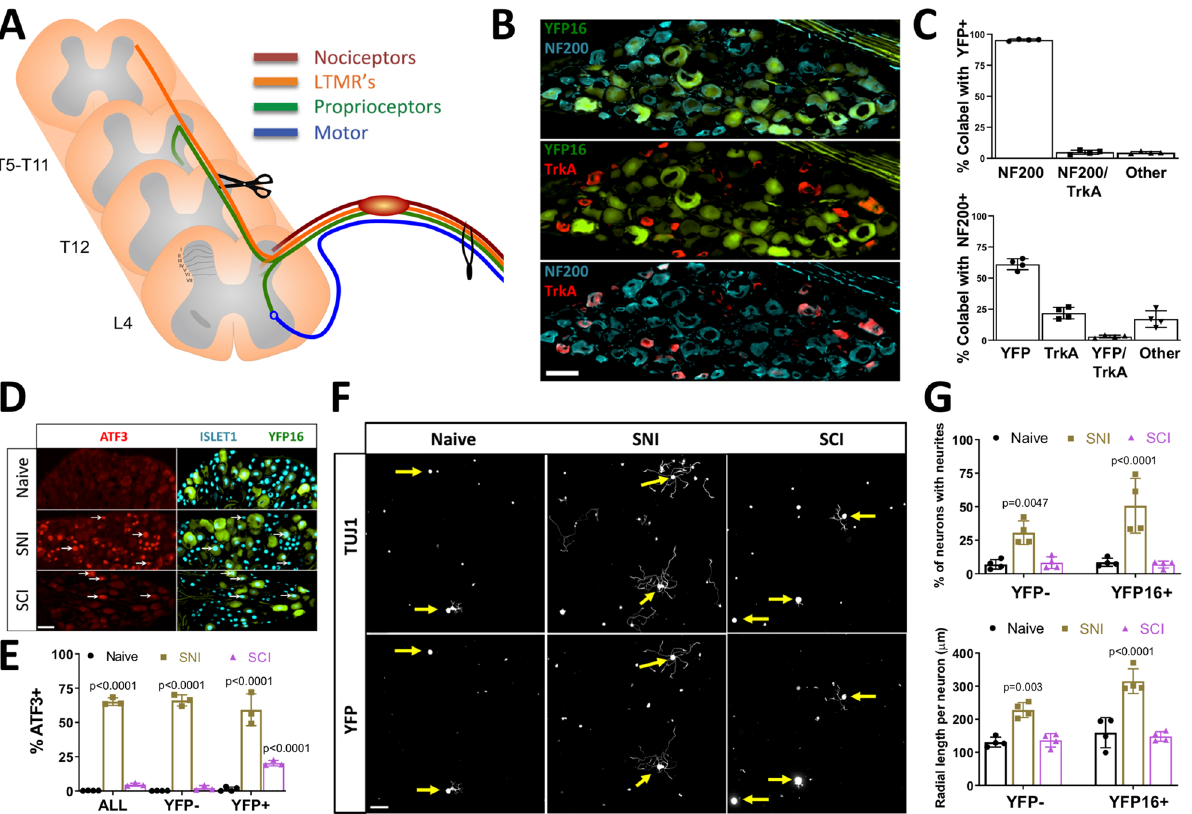
Figure 2. Spinal Cord Injury (SCI) does not induce a pro-growth state in ascending DRG sensory neurons in vitro. ( A ) Schematic of the experimental design and peripheral and central projects of major sensory neuron subtypes of L4 dorsal root ganglion (DRG) neurons. ( B ) Representative images of L4 dorsal root ganglion (DRG) neurons from Thy1YFP16 mice labeled with NF200 (blue) and TrkA (red) antibodies. ( C ) Quantification of ( B ) indicating percent overlap of YFP, NF200, and TrkA labeling in Thy1YFP16 mice (n = 4 mice). ( D ) Representative images of L4 DRG neurons labeled with ATF3 and Islet1 antibodies in Thy1YFP16 mice in naive or 3 days after sciatic nerve injury (SNI) or SCI. ( E ) Quantification of ( D ) indicating percentage of ATF3 positive, Islet-1 labeled neuronal nuclei in all neurons, as well as YFP negative and YFP positive neurons, for each condition (n = 3 mice/group; 2-way ANOVA). White arrowheads point to ATF3 positive neuronal nuclei. ( F ) Representative images of cultured cells from L4 DRG labeled for all neurons (TUJ1) and YFP positive neurons in naïve or 3 days after SNI or SCI. ( G ) Quantification of ( F ) indicating the percentage of neurons extending neurites and the average radial length of neurites, in YFP negative and YFP positive neurons, for